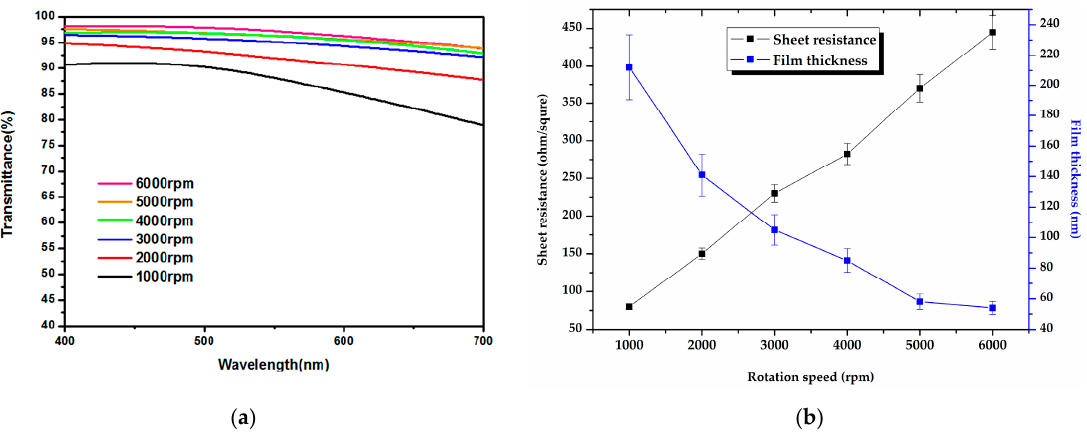
Figure 2. ( a ) Transmittance and ( b ) sheet resistance (R sq ) and film thickness for PEDOT:PSS of single layer films with different rotational speeds.